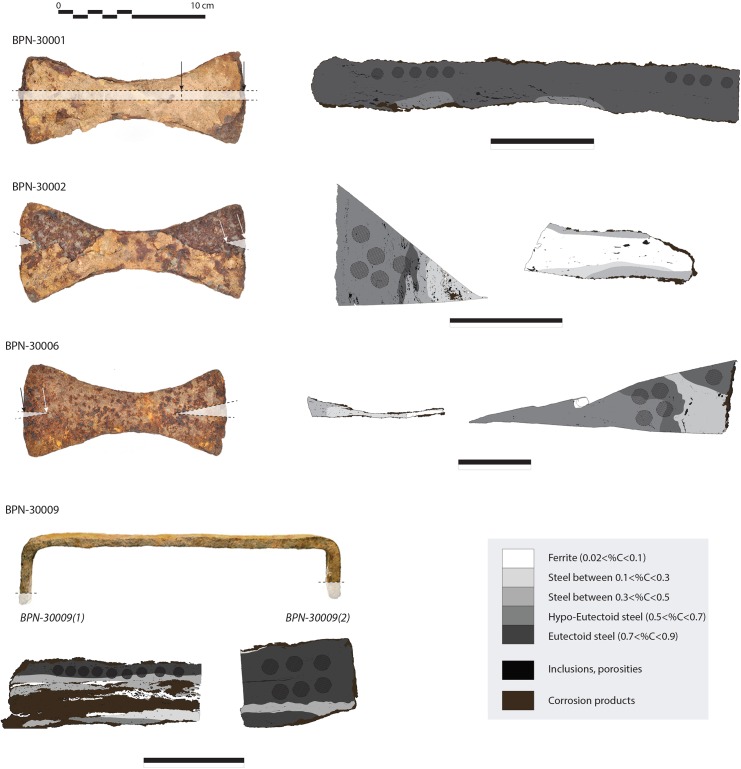
Documentation of the dated specimens.Sampled parts within each crampon are shown in white. Schematic drawings of the microscopic metallographic observation on the cross-section after Nital etching enlighten the distribution of the carbon content within the metal. The black marks within the metal of the most carburized samples, selected for the radiocarbon measurements, indicate the fingerprint of the drill samples. 2 dates were obtained for each crampon BPN-30001 and BPN-30002. Both samples BPN-30009(1) and BPN-30009(2) from BPN-30009 could be dated therefore providing 2 dates for the crampon.